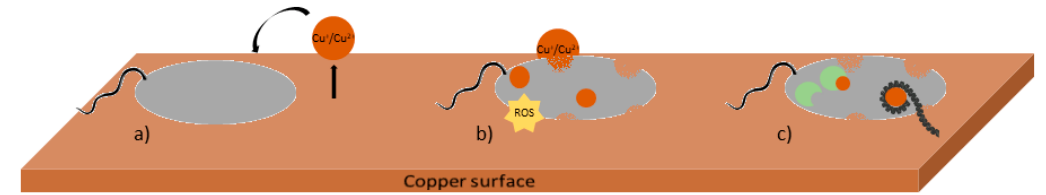
Figure 1. Sequential mechanisms involved in microbial-copper contact killing. ( a ) Release of copper ions (Cu + / Cu 2 + ) from the surface and interaction with the bacterial envelope; ( b ) bacterial envelope damage caused by copper ions and by the formation of reactive oxygen species (ROS), leading to the presence of copper ions intracellularly and ( c ) damage of nucleic acids caused by copper ions and inhibition of enzyme activity.